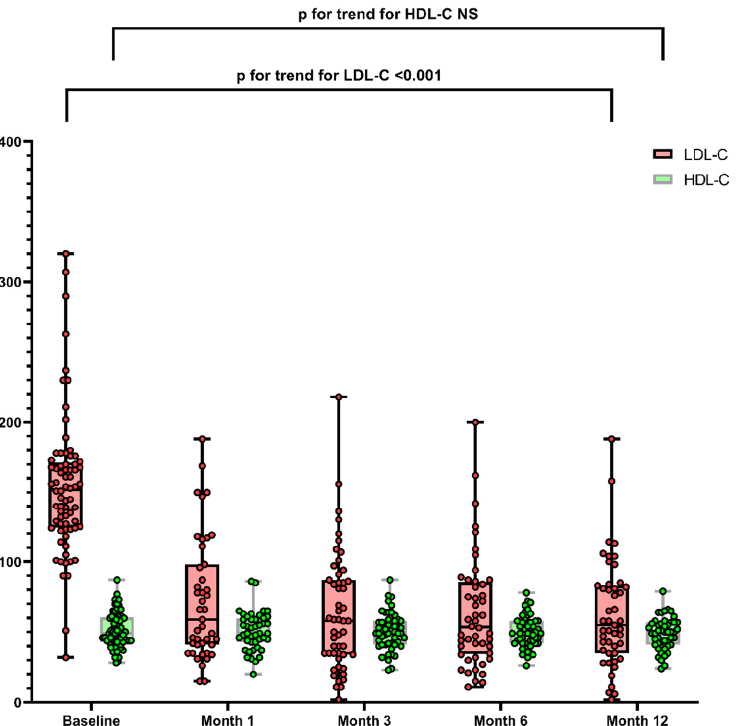
Figure 1. Evolution of LDL-C and HDL-C during follow-up of all included subjects. Values are expressed as median and interquartile range. Abbreviations: LDL-C: low-density lipoprotein cholesterol, HDL-C: high-density lipoprotein cholesterol, NS: non-significant.